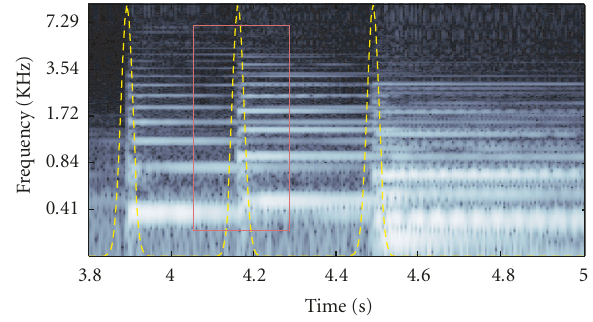
Figure 9: The constant- Q transform of a piano musical piece with labeled onsets. The dashed line is the onset trace, it corresponds to the ideal input for the peak-picking algorithm. The red box is a win- dow seen by the neural network for a particular time and particular frequency. This input window has a width of 200